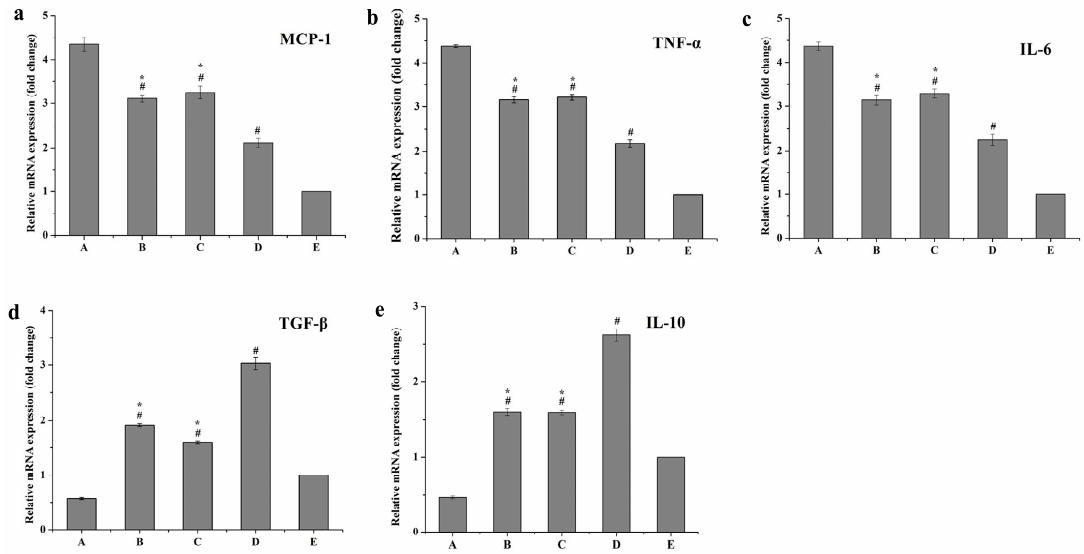
Figure 11. mRNA expression levels of pro-inflammatory factors (MCP-1, TNF- α , IL-6) and anti-inflammatory factors (TGF- β and IL-10). (A) positive control group; (B) curcumin solutions; (C) blank PS-containing carriers; (D) Cur-mNLCs; (E) negative control group; # p < 0.01, compared with A, * p < 0.01, compared with D; ( a ) RT-qPCR assay for mRNA levels of MCP-1; ( b ) RT-qPCR assay for mRNA levels of TNF- α ; ( c ) RT-qPCR assay for mRNA levels of IL-6; ( d ) RT-qPCR assay for mRNA levels of TGF- β and ( e ) RT-qPCR assay for mRNA levels of IL-10 (mean ± SD, n = 6). mRNA expression levels (fold change) of all pro-inflammatory cytokines were remarkably reduced in the curcumin solutions group (B), blank PS-containing carriers group (C) and Cur-mNLCs group (D), compared with the positive control group (A) ( p < 0.01 for Group B, C, or D vs. Group A). The combination of curcumin and PS (Cur-mNLCs) exerted a more potent inhibiting effect, in comparison with curcumin or PS alone ( p < 0.01 for Group B or C vs . Group D). Curcumin solutions (Group B), blank PS-containing carriers (Group C) and Cur-mNLCs (Group D) all enhanced the mRNA expression levels of anti-inflammatory cytokines, compared with the positive control group ( p < 0.01 for Group B, C, or D vs. group A). Among the three treatment groups (Groups B, C, and D), Group D displayed the most significant effects ( p < 0.01 for Group B or C vs . Group D).